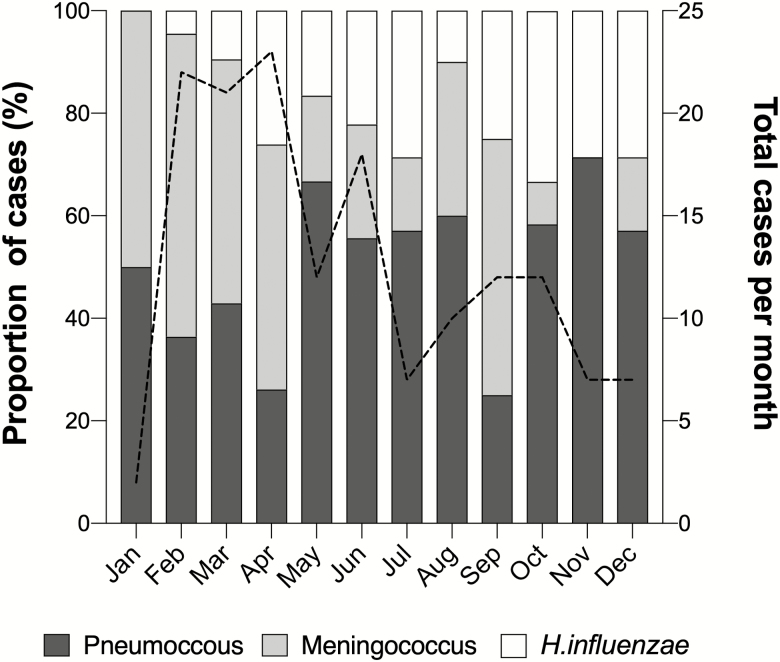
Monthly distribution of suspected pediatric bacterial meningitis cases for the period 2010 to 2016 within 5 sentinel hospitals across Nigeria. The percentage of pediatric bacterial meningitis (PBM) cases seen across 5 hospitals in 5 Nigerian states, caused by Streptococcus pneumoniae, Neisseria meningitidis, and Haemophilus influenzae per month. A black dashed line indicates the total number of PBM cases per month throughout the surveillance period.